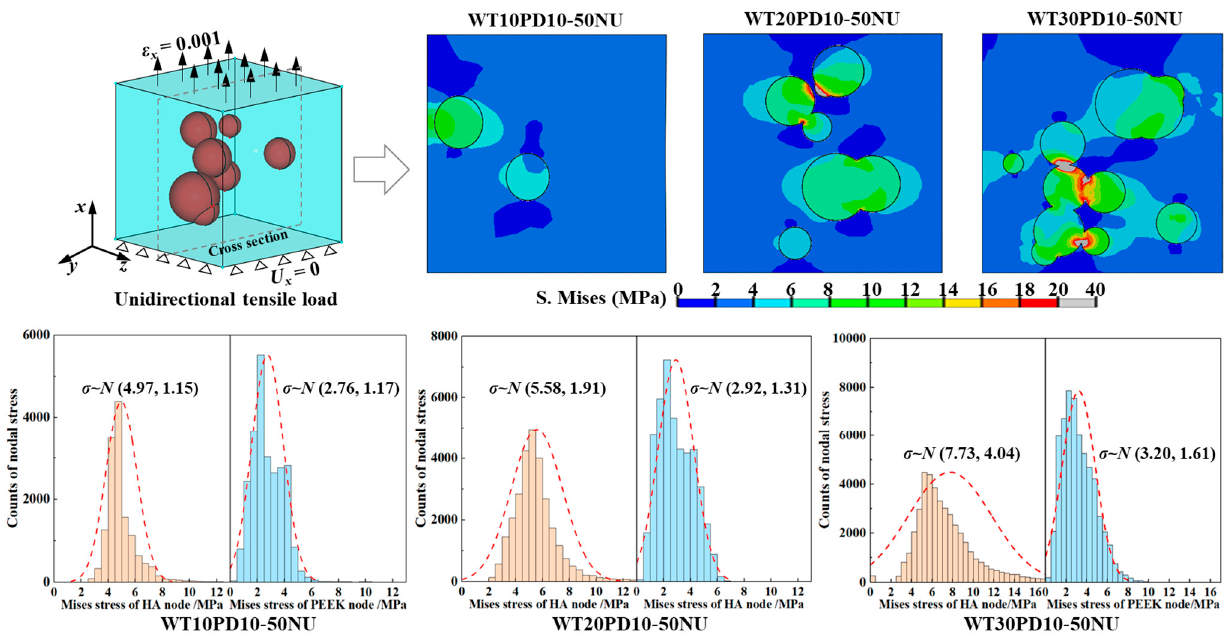
Figure 7. The von Mises stress distribution of composite micromodel and stress statistics of interface nodes.